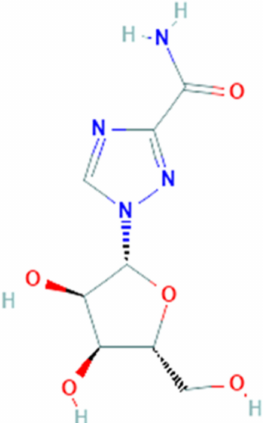
Figure 7. Chemical structure of